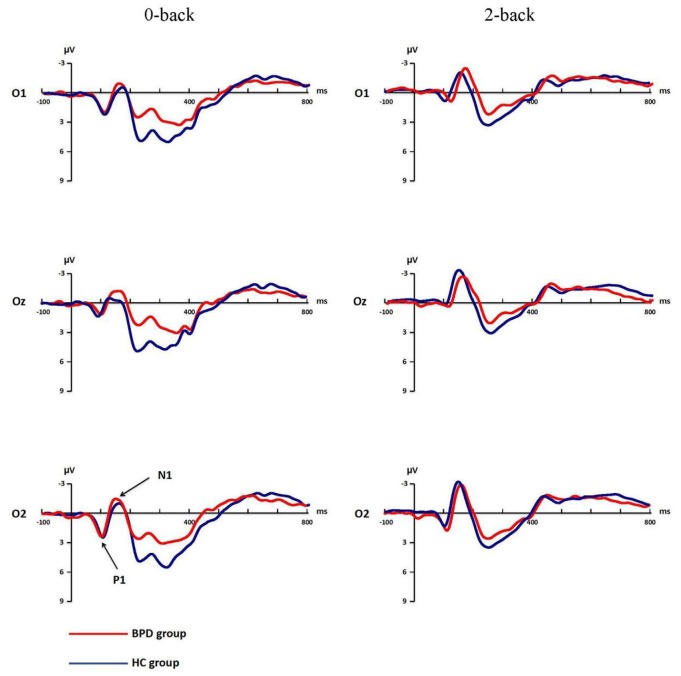
Grand-average event-related potential (ERP) waveforms of P1, N1 for 0-back and 2-back in borderline personality disorder (BPD) and healthy control (HC) groups. The electrodes of O1, Oz and O2 were chosen to record P1 and N1. P1 and N1 changed under 0-back and 2-back in both groups.